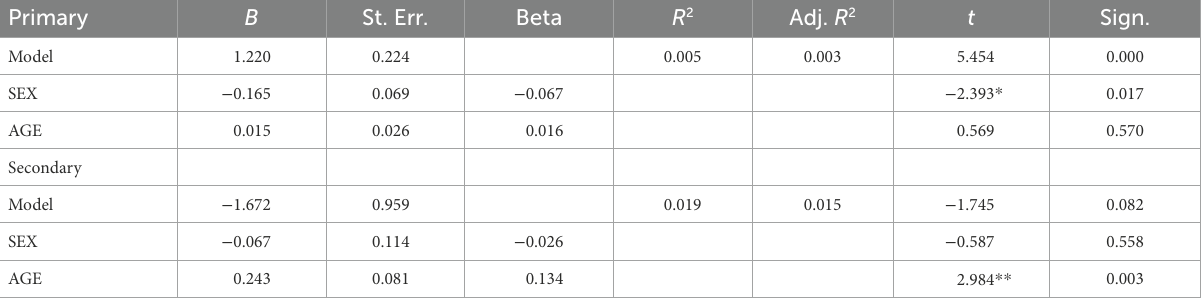
TABLE 5 Linear regression model: sex and age as predictors of teacher presence in Classroom Drawing scores in primary and secondary school children. Primary B St. Err.